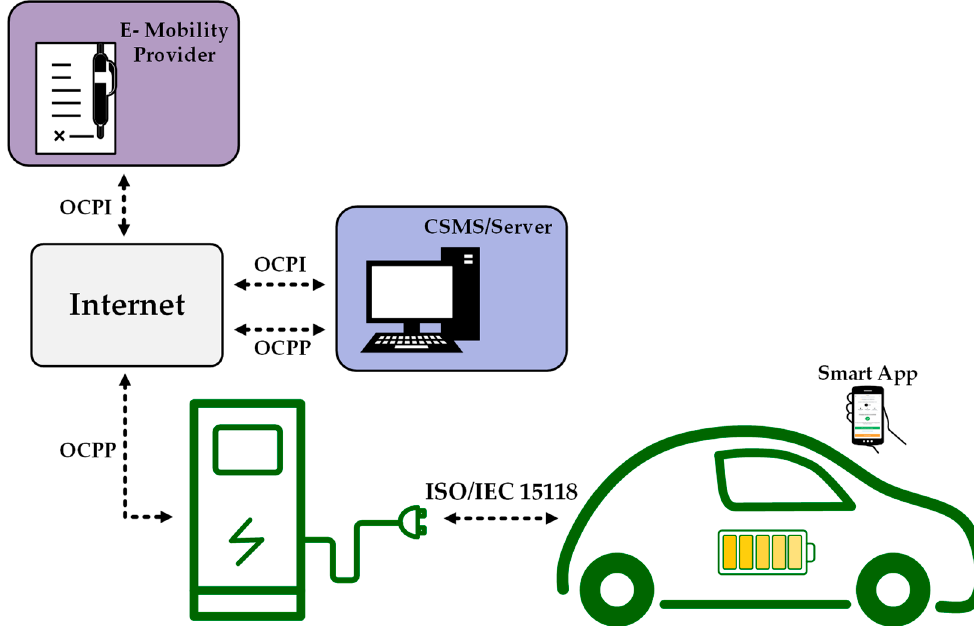
Figure 11. Communication protocols used during the charging procedure.